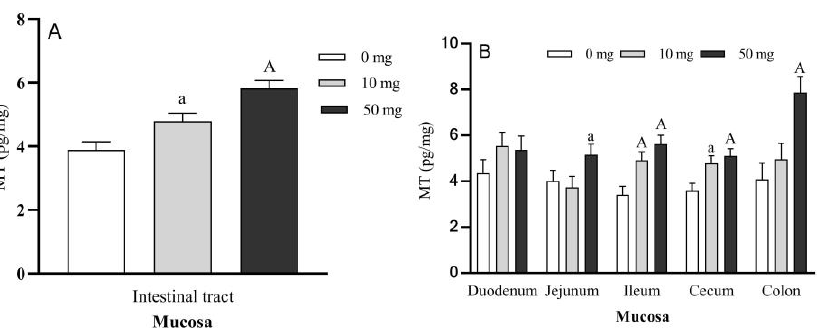
Figure 6. Effects of different doses of 5-HTP duodenal perfusion on MT content in sheep intestinal mucosa. ( A ). MT level in entire intestinal tract mucosa, ( B ). MT levels in mucosa of duodenum, jejunum, ileum cecum and colon, respectively. The data were expressed as LSM ± SEM ( n = 6). Small letters indicate p < 0.05, capital letters indicate p < 0.01 vs. their respective control